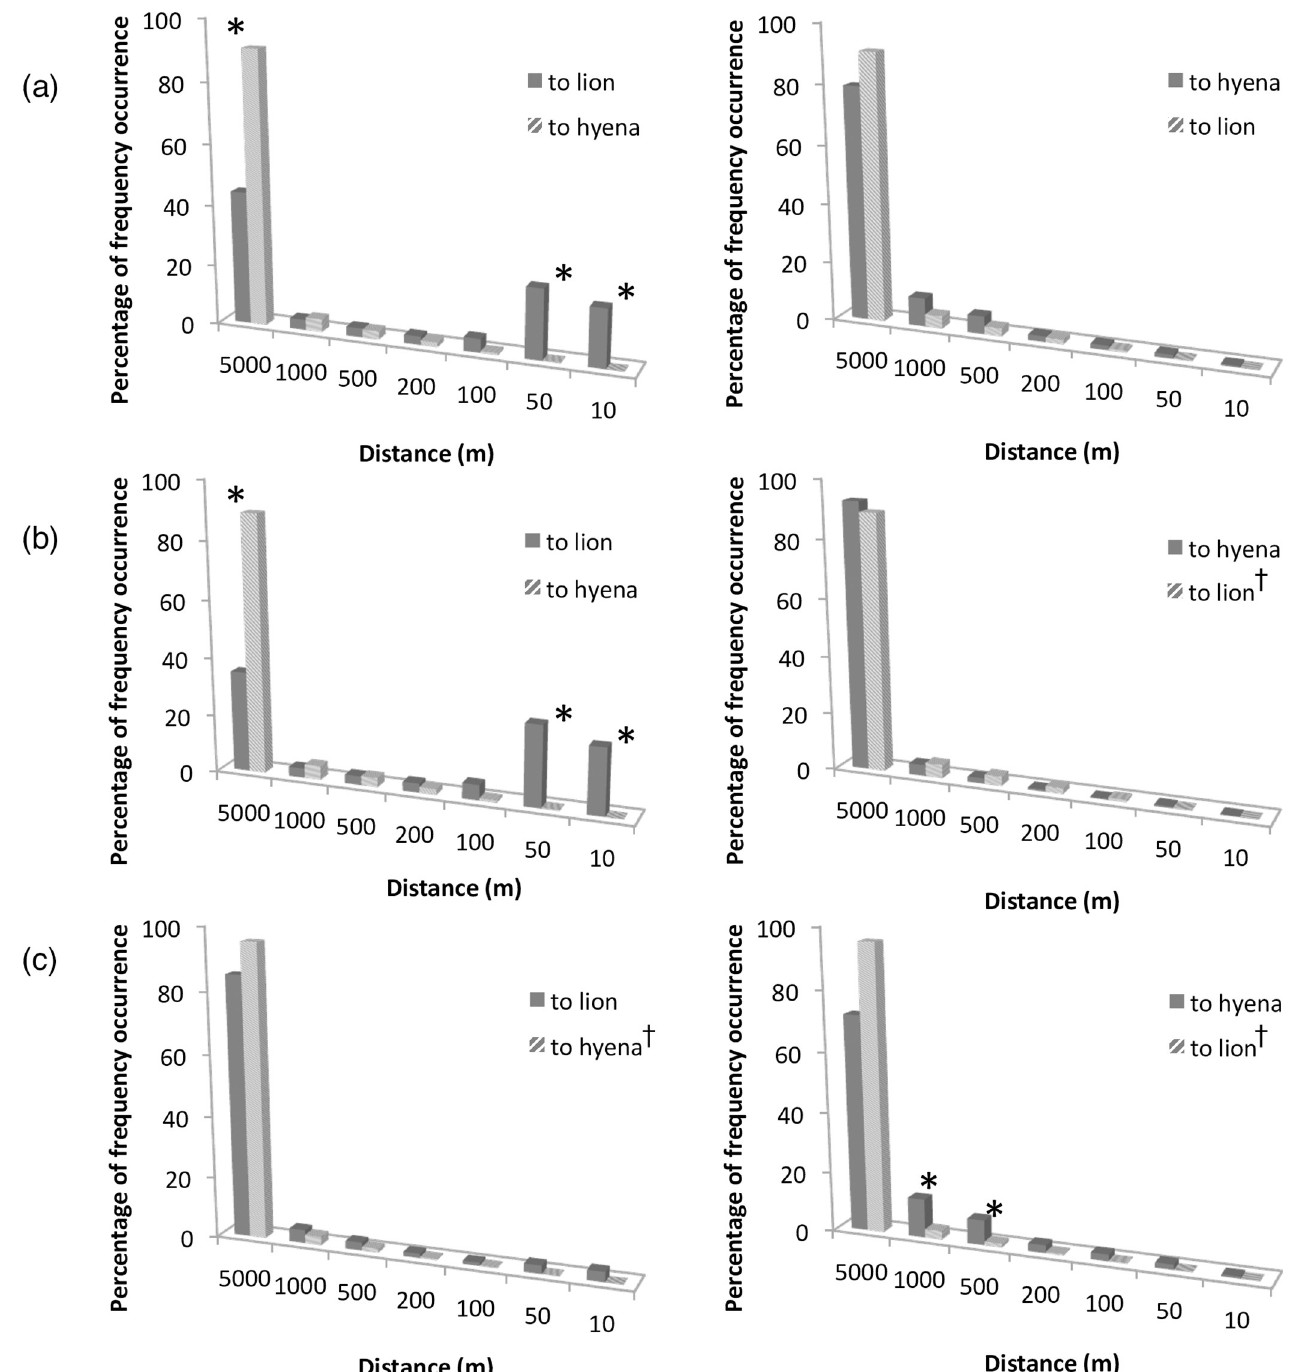
Fig 7. Frequency of time-matched distances between lions and spotted hyenas. Percent frequency occurrence of time-matched distances from lions (left side figures) and spotted hyenas (right side figures) to collared individuals at distance intervals of 0-10 m, > 10-50 m, > 50-100 m, > 100-200 m, > 200-500 m, > 500- 1000 m, and > 1-5 km. Dark grey bars reflect frequency of distances to conspecifics, and hatched bars frequency of distances to competitors. Plots represent the (a) overall percentage frequency occurrence, (b) Etosha groups, and (c) Chobe/Linyanti groups. Asterisks denotes the significant difference between competing groups for that interval; and a dagger indicates which competing group has the greater percent frequency occurrence between 0-5 km. Statistical results are presented in S12 Table.